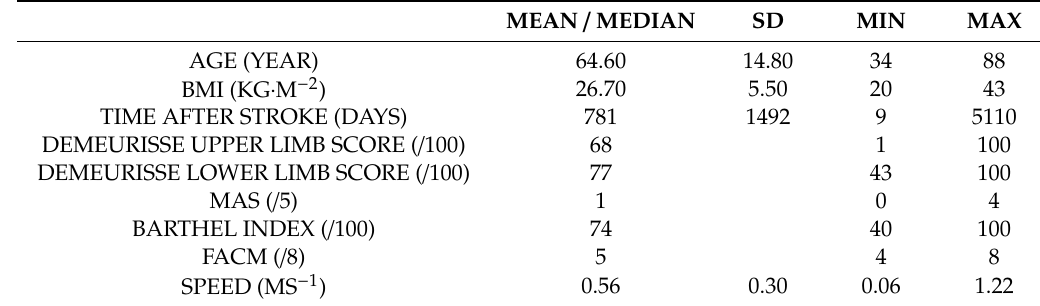
Table 1. Characteristics of the population. SD: standard deviation; BMI: body mass index; FACm: functional ambulation classification modified; MAS: modified Ashworth